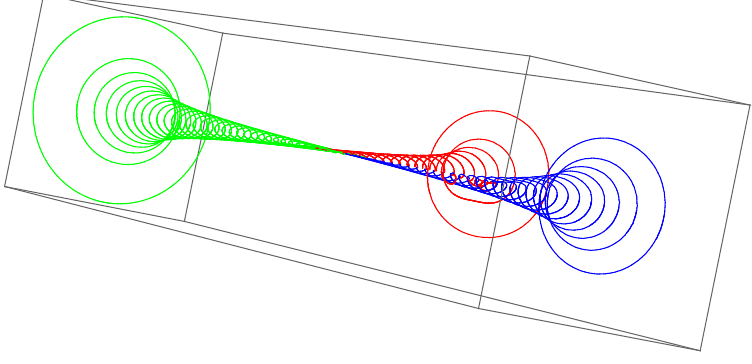
Figure 8 . The M2-branes junction ending on three di(cid:11)erent